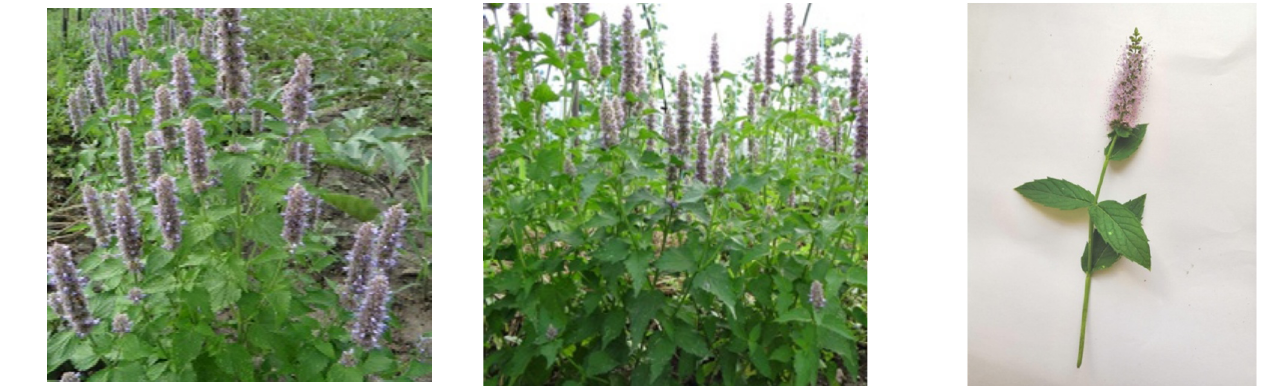
Figure 10. A. foeniculum AdB plant used in the present